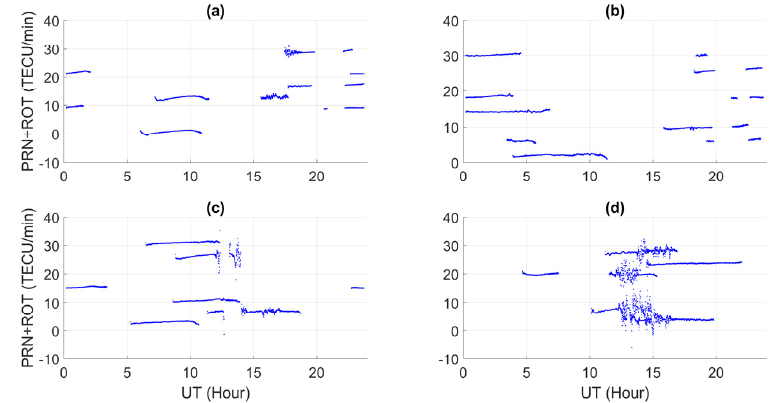
Figure 2. The time series of ROT for all of the observed GPS satellites at the QION site (8 October 2003). The vertical axis is the sum of the ROT value and PRN number of the corresponding satellite. The PRN numbers of each subfigure are as follows: ( a ) 1, 9, 13, 17, 21, 29; ( b ) 2, 6, 10, 14, 18, 26, 30; ( c ) 3, 7, 11, 15, 27, 31; ( d ) 4, 8, 20, 24, 28. ISPRS Int. J. Geo-Inf. 2016 , 5 , 237